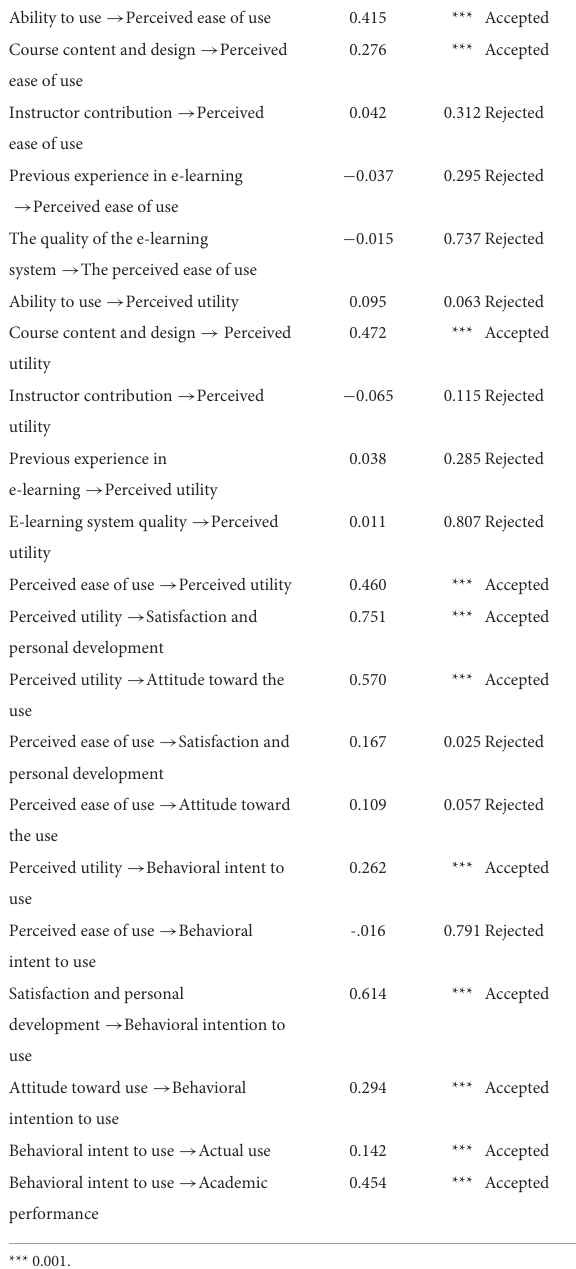
Path coefficient P